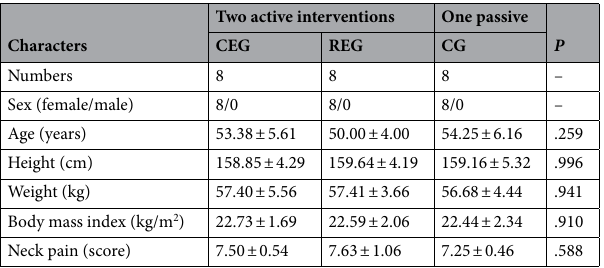
Table 1. Characteristics of study subjects. Data are means ± standard deviation. CEG, corrective exercise group; REG, resistance exercise group; CG, control group. P values are from Kruskal–Wallis